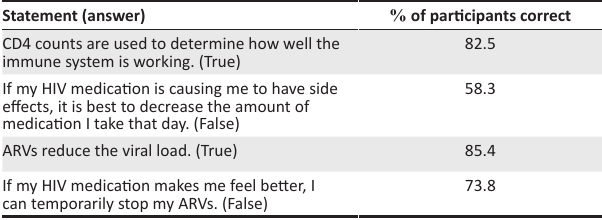
TABLE 2 : Participant answers to knowledge